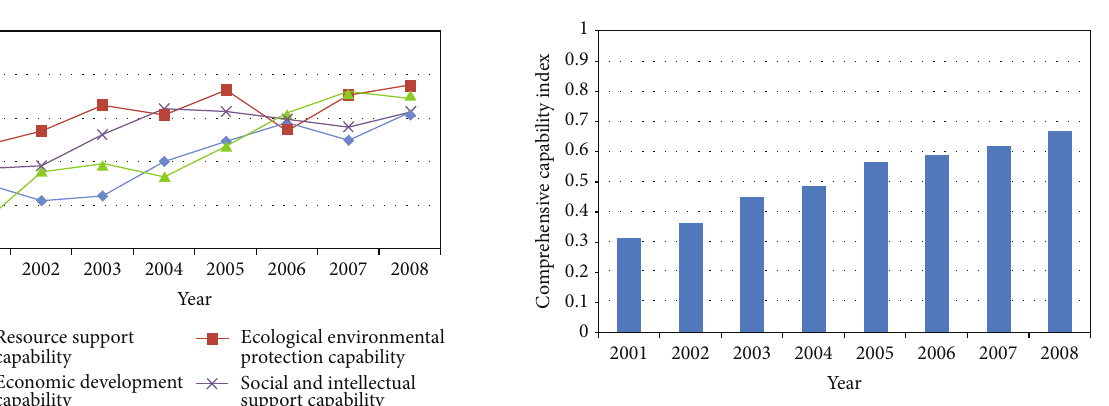
Figure 4: The comprehensive index of supporting systems.